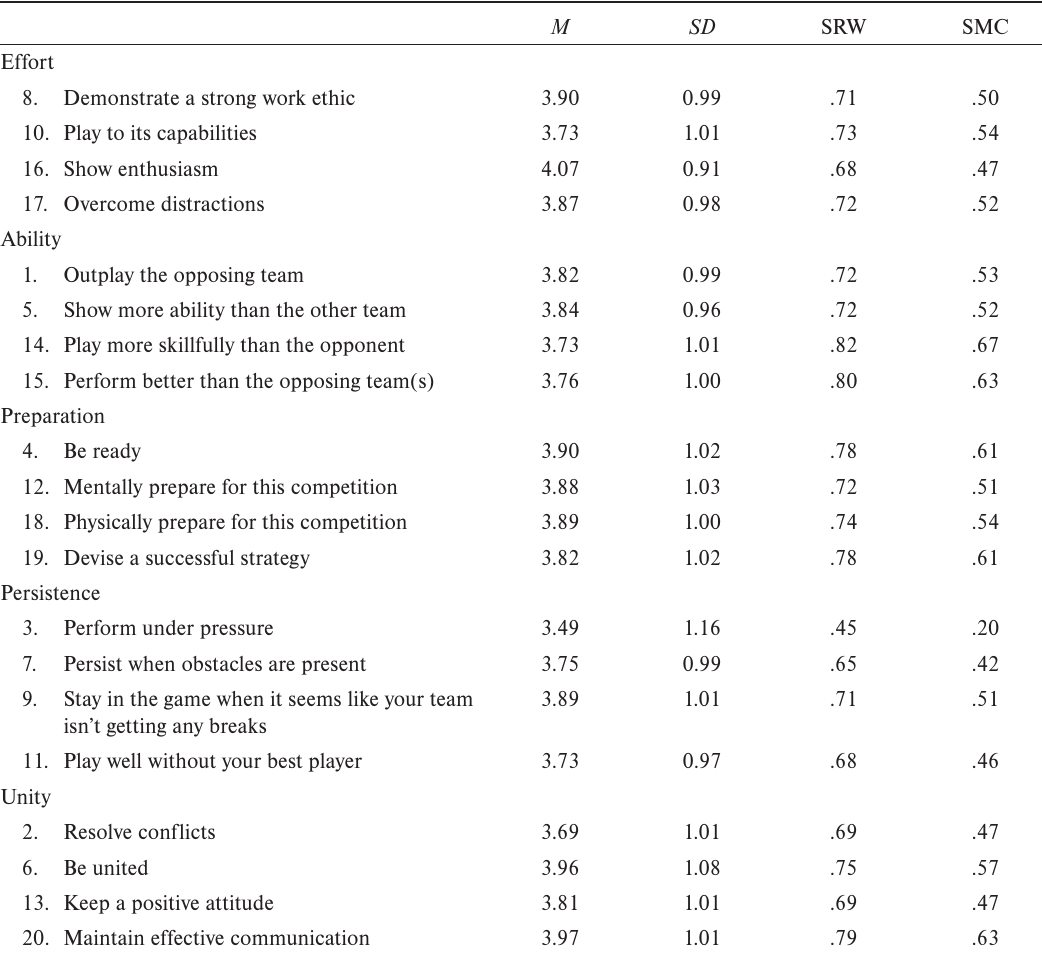
Statistical characteristics of items used in the CFA for the T-CEQS